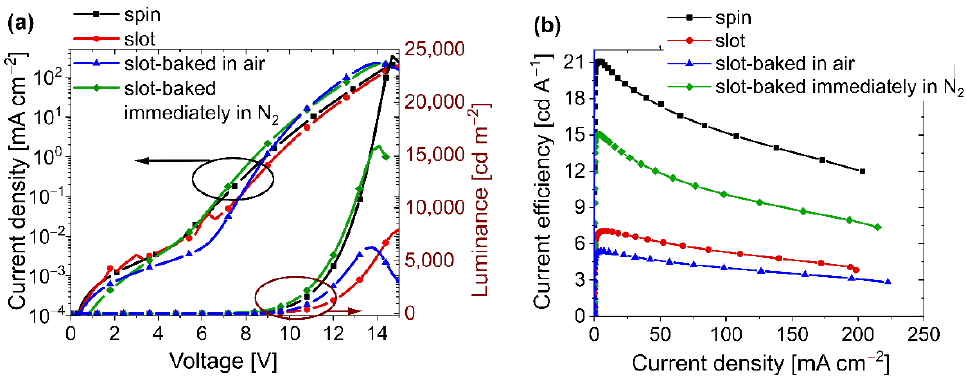
Figure 8. Working parameters of OLEDs based on emissive layer (PVK + 25 wt.% SpiroAC-TRZ + 2 wt.% Ir) prepared by means of spin- or slot-die coating technique. Device structure: ITO/PEDOT:PSS (20 nm)/EML (75 nm)/Bphen (40 nm)/Liq (2 nm)/Ag (100 nm). ( a ) Current density – voltage charac- teristics (left) and luminance – voltage characteristics (right); ( b ) Current efficiency vs. current den- sity.